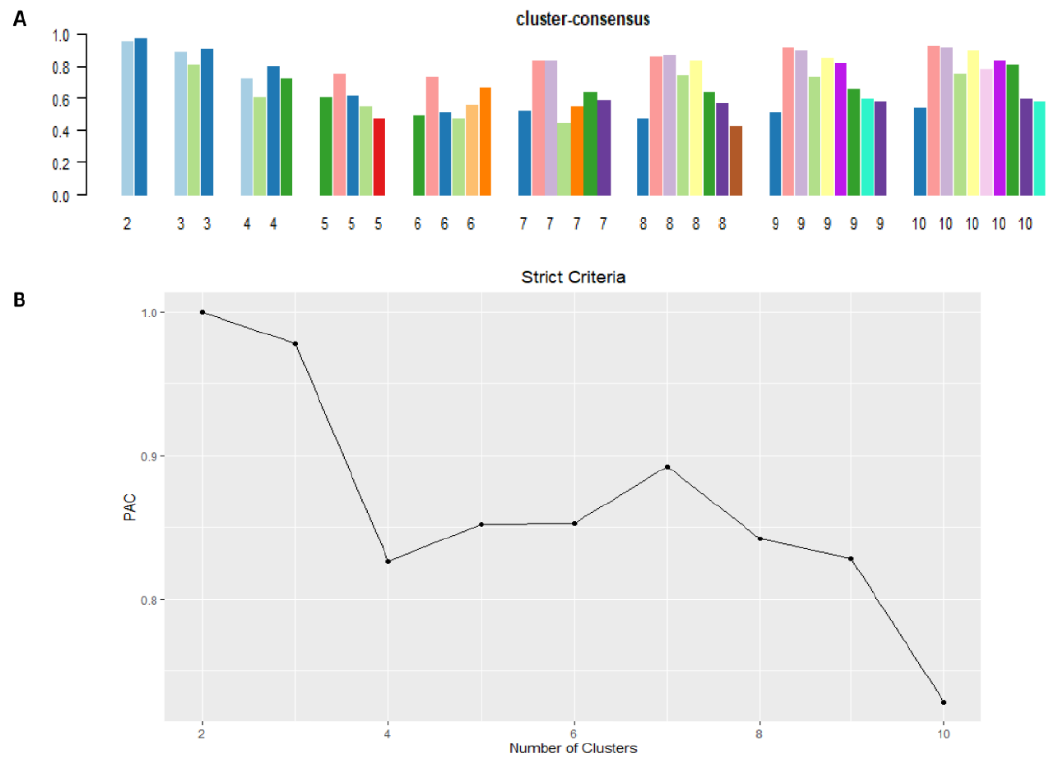
Figure 2. ( A ) The bar plot represents the mean consensus score for different numbers of clusters (K ranges from two to ten); ( B ) The PAC values assessing ambiguously clustered pairs. Cluster 1 had 2033 (18%) patients, cluster 2 had 3064 (28%) patients, and cluster 3 had 6002 (54%) patients. Table 1 shows the clinical characteristics of the three identified clus- ters. The distribution of all clinical variables significantly differed among the three clus- ters. Table 1. Clinical characteristics. Patient Characteristics